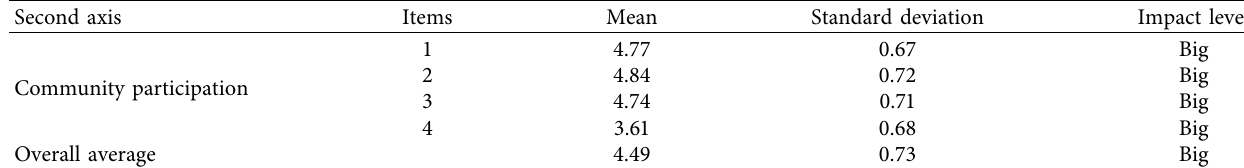
Table 4: Arithmetic averages and standard deviations of the second axis.